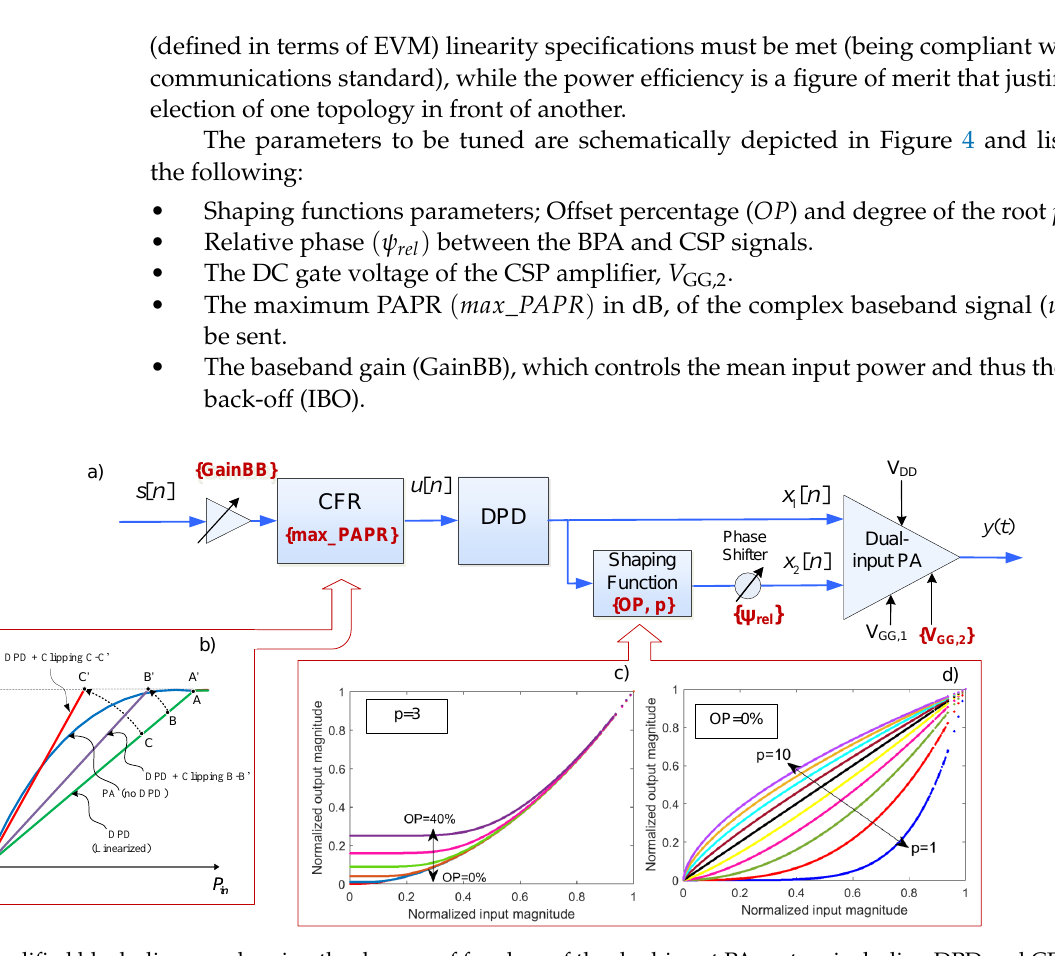
Figure 4. Simplified block-diagram showing the degrees of freedom of the dual-input PA system including DPD and CFR: ( a ) Simplified block diagram of the LMBA transmitter including CFR, DPD, a shaping function and a phase shifter; ( b ) AM-AM characteristics for different baseband gains and clipping values; ( c ) Shaping function input-output characteristics for different values of OP ; ( d ) Shaping function input-output characteristics for different values of p